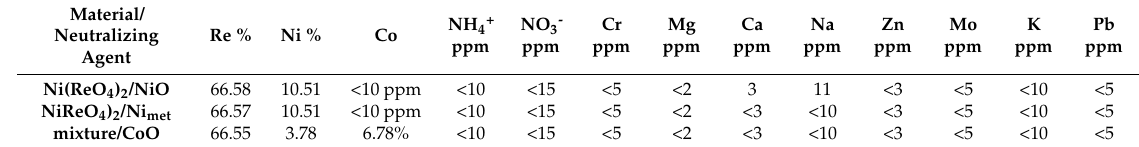
Table 21. Composition of nickel(II) perrhenate and its mixture with cobalt.